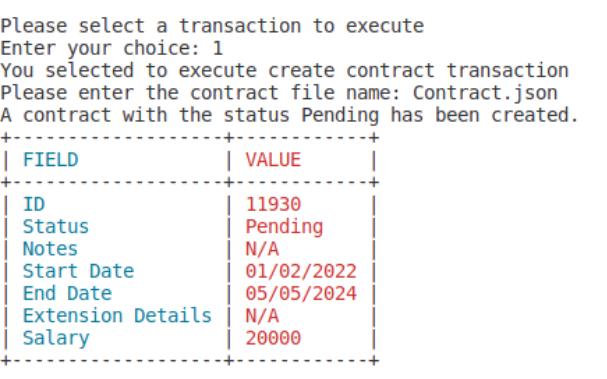
Figure 4. A list of the implemented transactions for the smart contract.